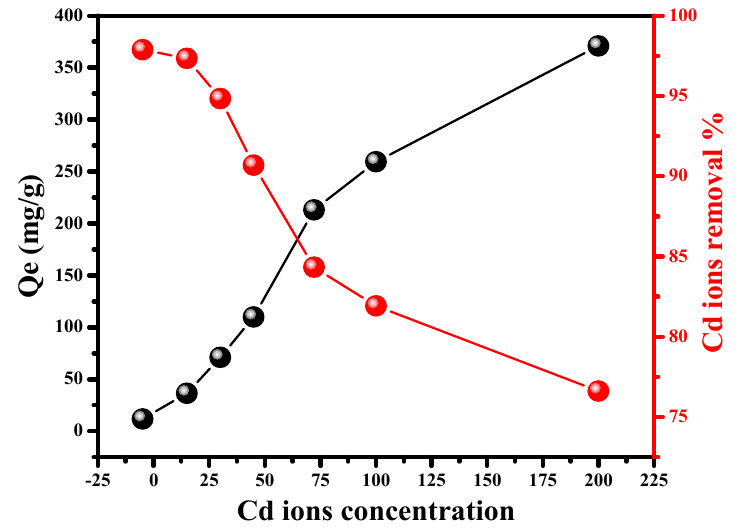
Figure 6. Influence of Cd (II) initial concentration.